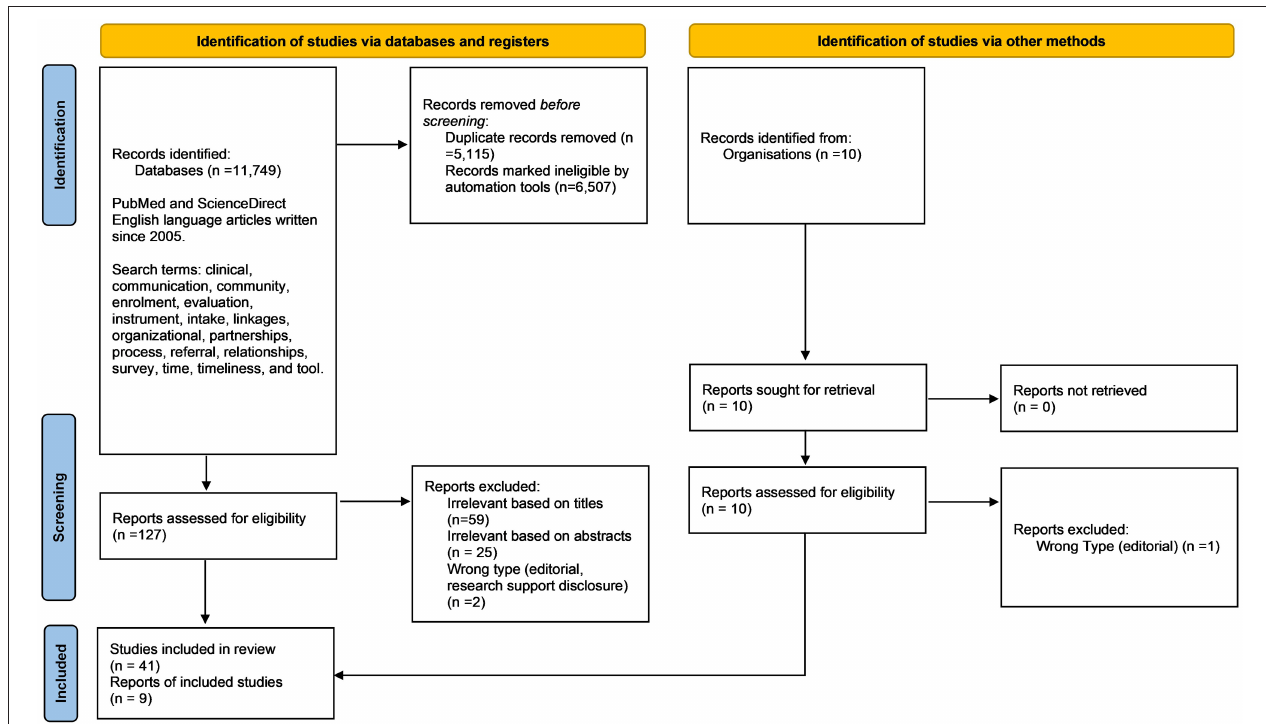
FIGURE 1 | PRISMA flow diagram for the systematic review detailing the search process, number of sources identified, screened, and